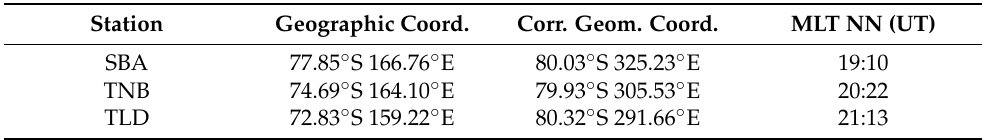
Figure 1. Location of the three Antarctic sites SBA, TNB and TLD. The geographic and the corrected geomagnetic coordinate systems are indicated as dashed and solid lines, respectively. Table 1. Geographic, IGRF21 corrected geomagnetic coordinates and time in UT of the magnetic local noon for the three stations.